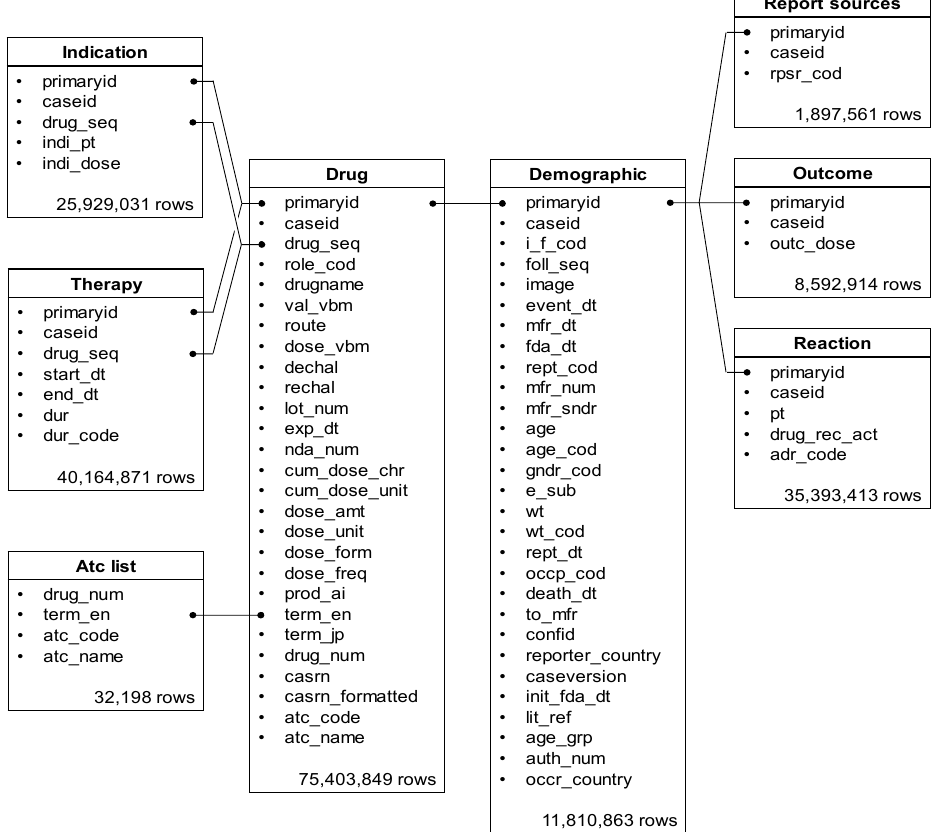
Figure 1. Eight information tables from the United States Food and Drug Administration Adverse Event Reporting System (FAERS) database. The number of rows equals the number of reports obtained between April 2004 and September